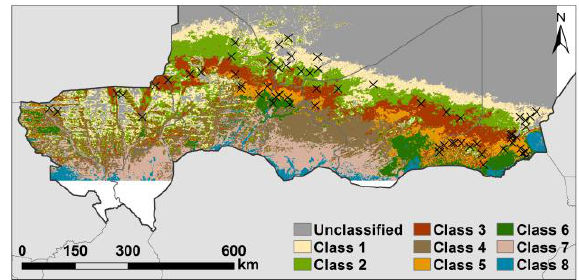
Figure 6. ISODATA classification result. Unclassified refer to non-vegetated area (see 2.3.2)